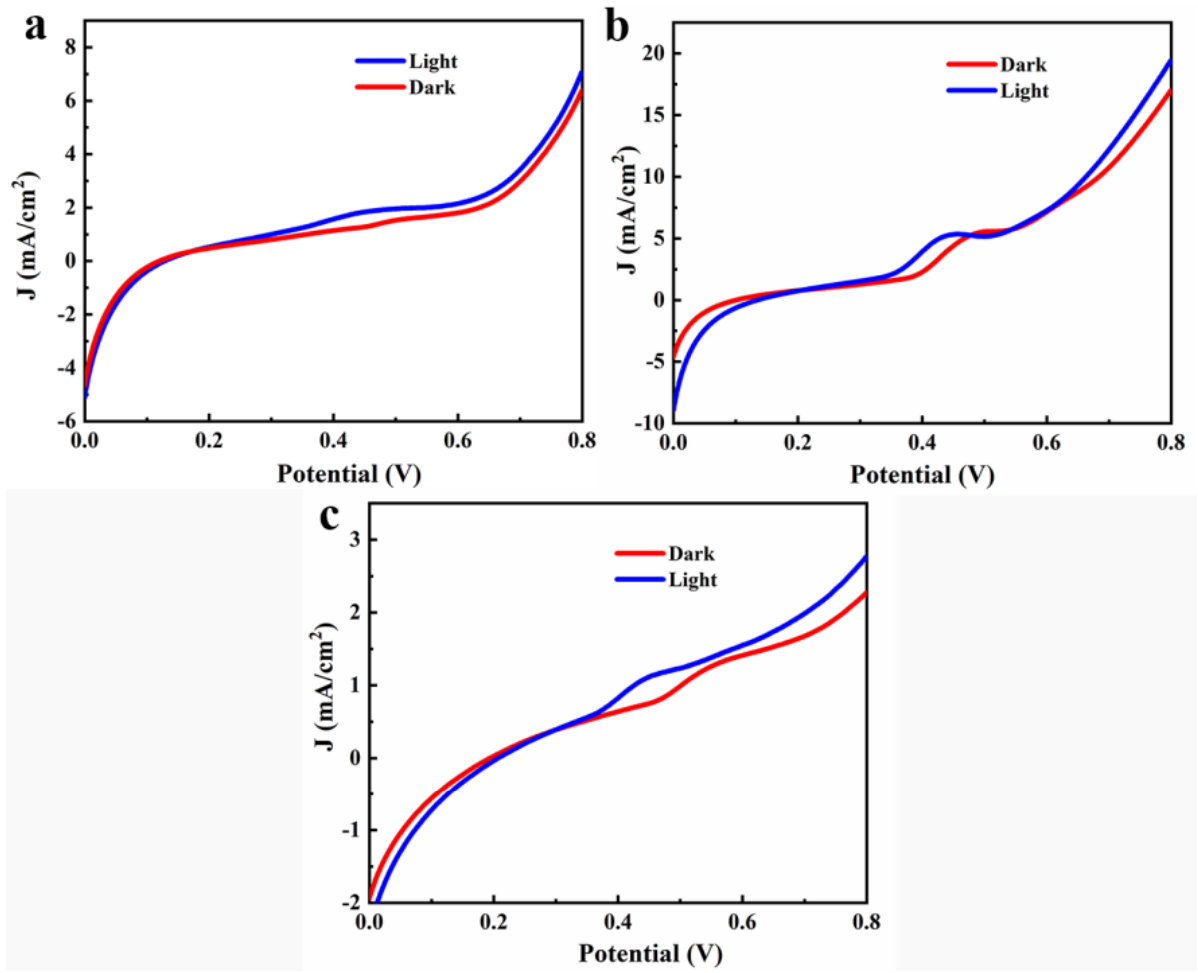
Figure 5. J – V curves of the TiO 2 layer at different spin-coating speeds: ( a ) 2000; ( b ) 3000; ( c ) 4000 rpm.